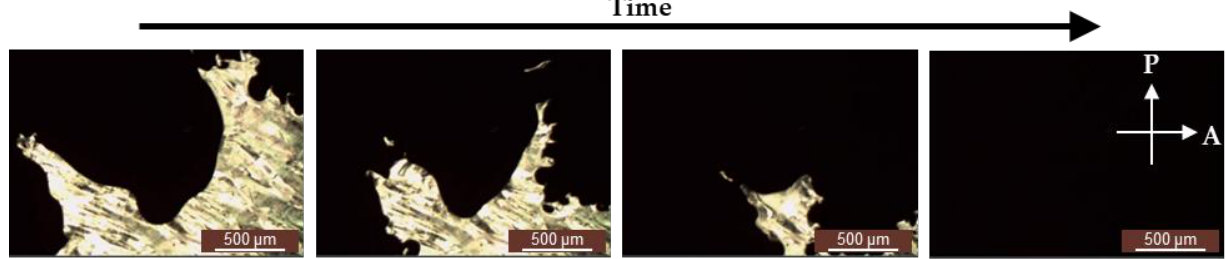
Figure 4. Dynamic images of nematic LCs that were exposed to acetone by a polarizing optical microscope under crossed